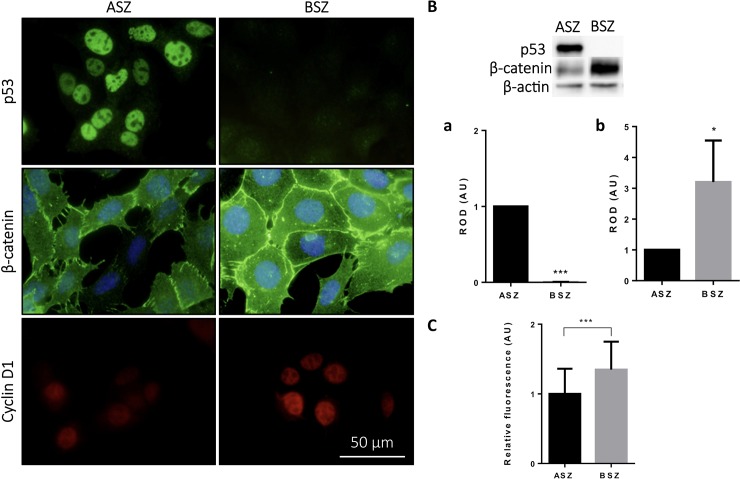
Expression of p53, β-catenin and ciclin D1 in BCC mice lines.(A) Expression pattern of p53, β-catenin and ciclin D1 on ASZ and BSZ cells by immunofluorescence. Scale bar: 20um. (B) Protein quantification by Western Blot of (a) p53 and (b) β-catenin. Load control: β-actin. (C) Relative fluorescence of cyclin d1 expression by immunofluorescence. *p< 0.05; ***p< 0.001.